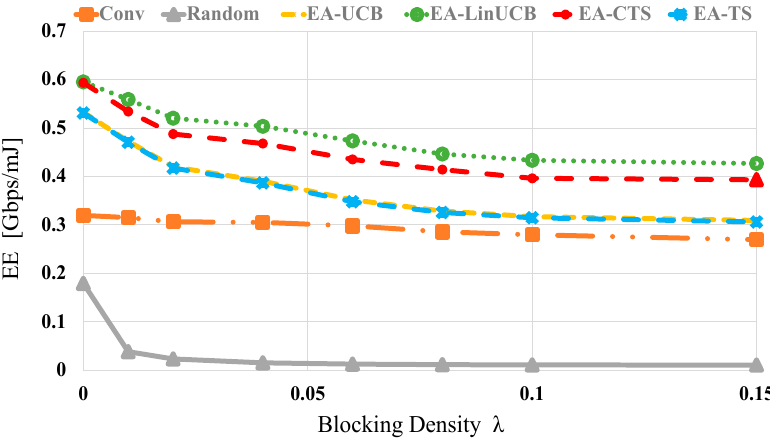
Figure 9. EE versus blocking density for EA-UCB, EA-TS, EA-LinUCB, and EA-CTS using 60 devices.